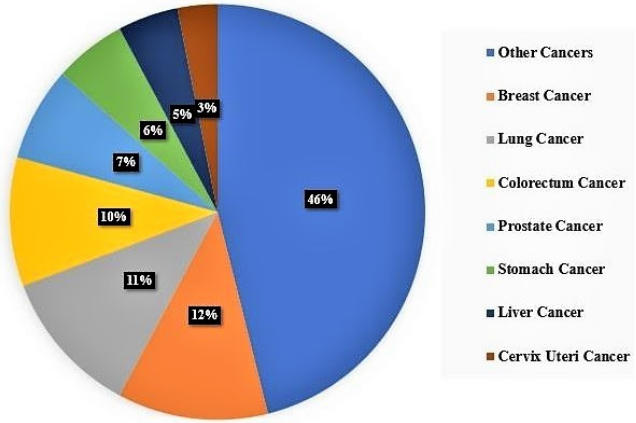
Figure 1. Facts and Statistics of several cancers.